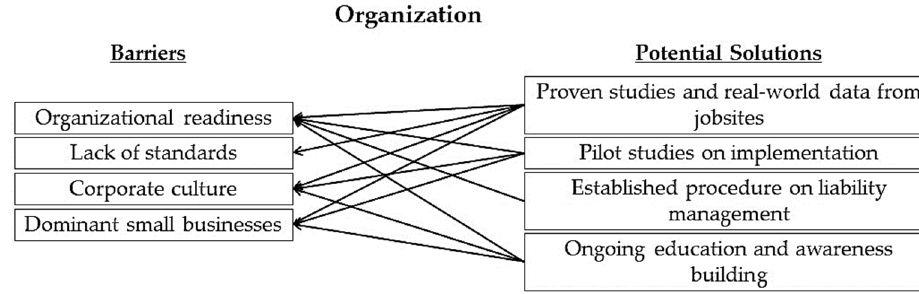
Figure 4. Mapping of potential solutions to identified barriers in the organization category.